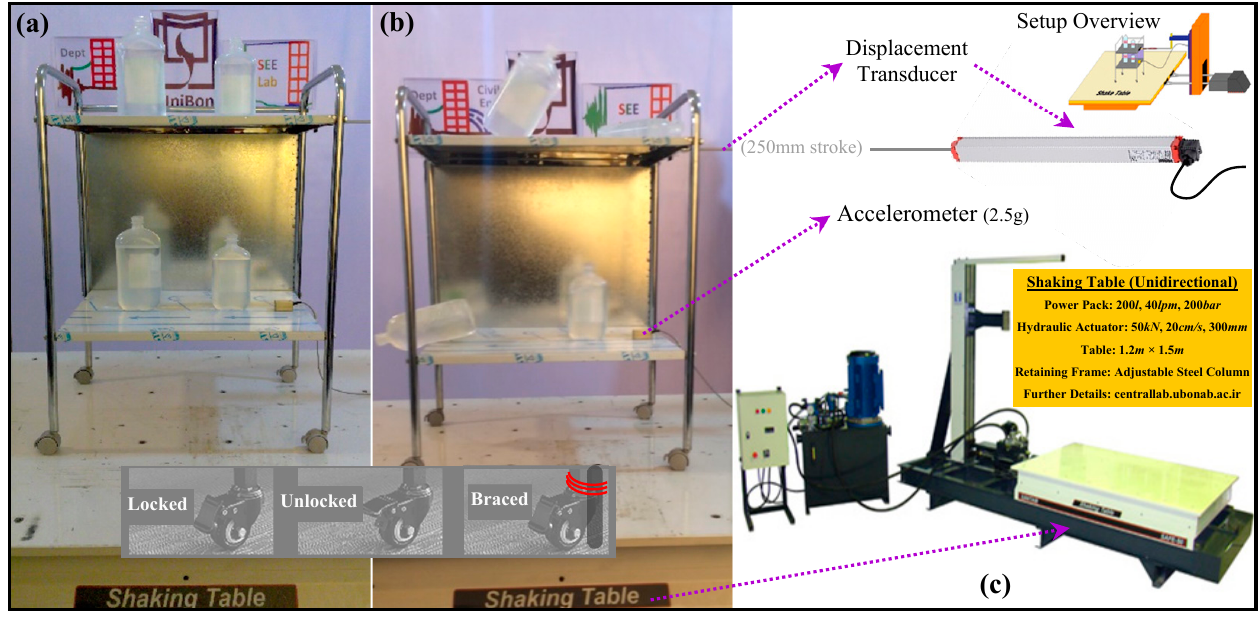
Figure 6. The hospital cart on the shaking table: ( a ) before and ( b ) during an experiment; ( c ) the technical details regarding the instrumentation and the mechanical system of the shaking table.